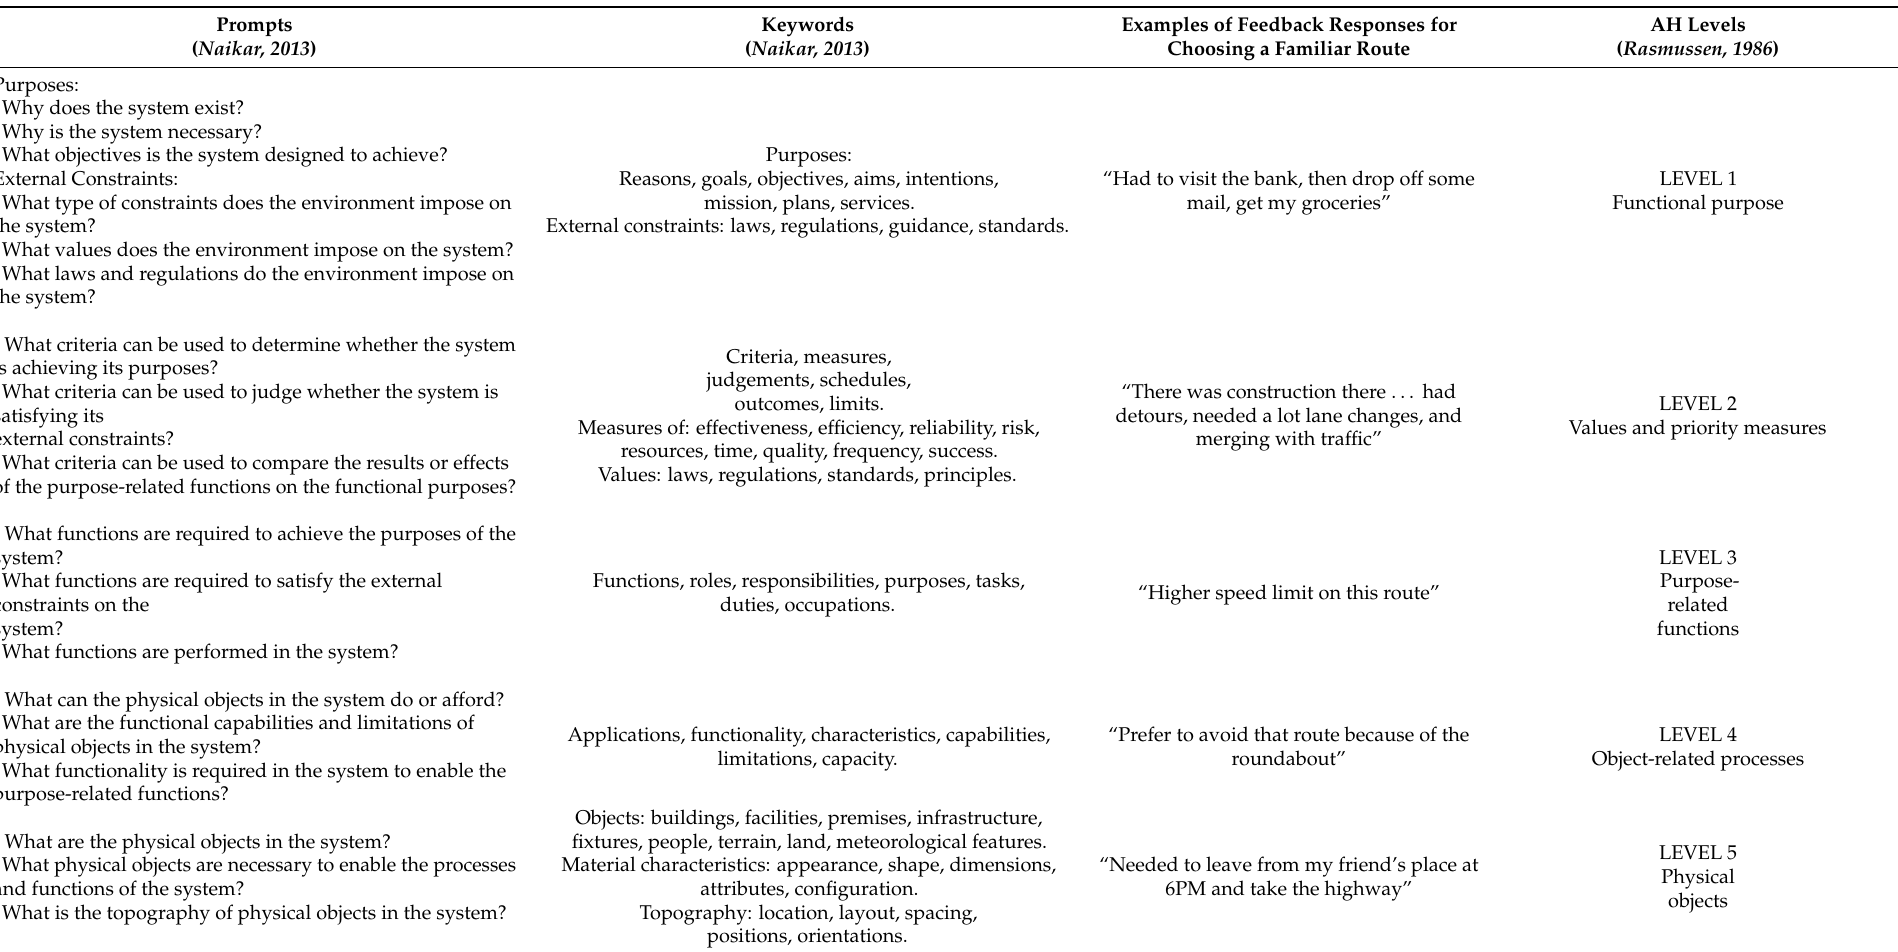
Table 3. Example showing how the prompts and keywords developed by Naikar was used to build an abstraction hierarchy for route familiarity from the familiarity feedback responses provided by older